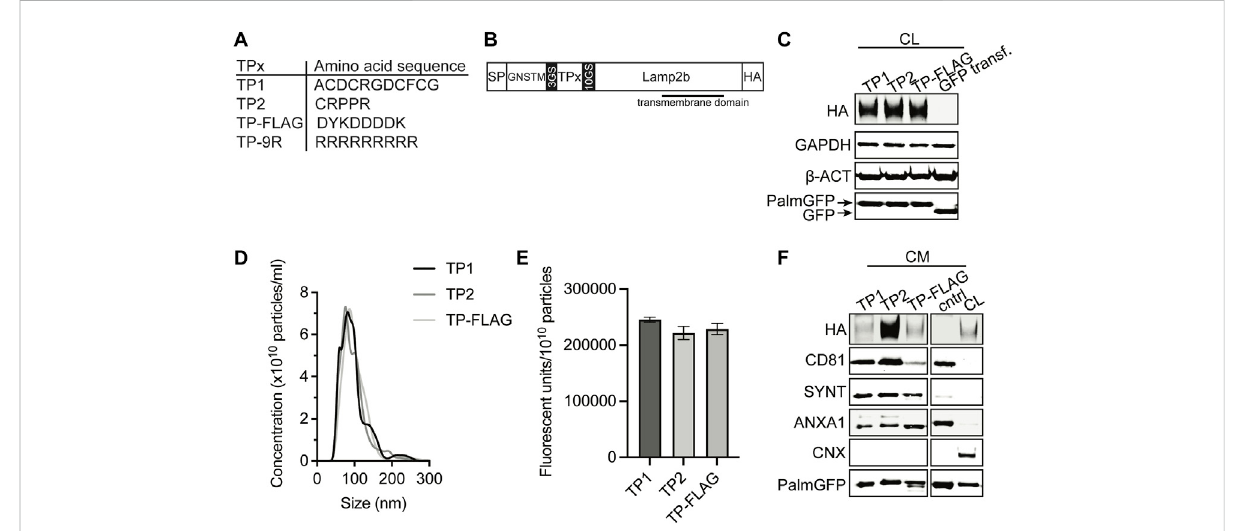
FIGURE 6 Generation of EVs expressing targeting peptides for endothelial cells. (A) Amino acid sequence of TP1, TP2, TP-FLAG, which was included as negative control, and TP-9R. (B) Schematic of constructs expressed on EVs consisting of a speci fi c targeting peptide (TPx) connected to transmembrane protein Lamp2b, fl anked by a N-terminal signal peptide (SP) and GNSTM glycosylation sequence, and C-terminal HA-tag. (C) Representative western blot analysis showing expression of HA-tag and PalmGFP in cell lysate (CL) harvested from CPC lines stably expressing PalmGFP + and speci fi c TPs. CPCs transduced with GFP were included as negative control. GAPDH and beta-actin (ß-ACT) were included as house- keeping proteins. (D) Representative NTA plots showing the size distribution and particle concentration of concentrated conditioned medium (CM) derivedfromPalmGFP + TP-expressing CPCs. (E) GFP fl uorescenceper10 10 particlesdeterminedinCMderived fromPalmGFP + TP-expressingCPCs (n = 2). Data are displayed as mean ± SD. (F) Representative western blot analysis showing expression of HA-tag, PalmGFP, CD81, Syntenin-1